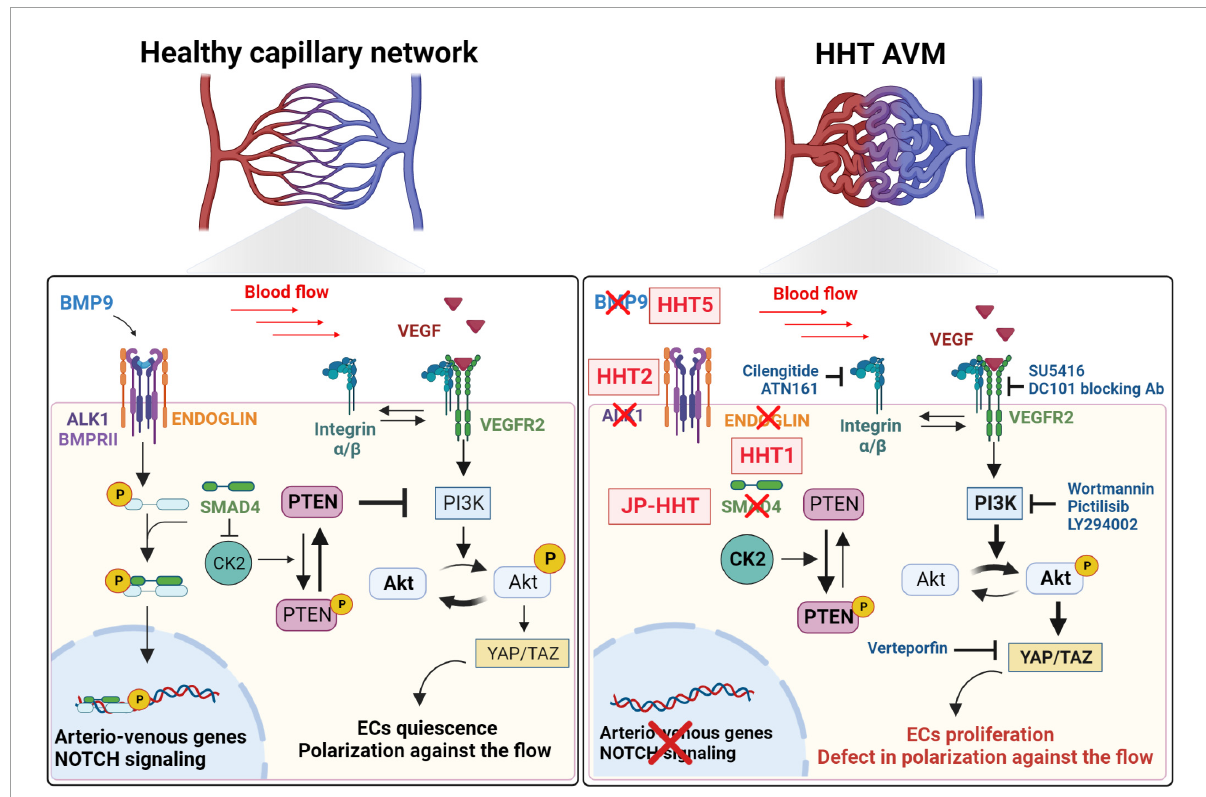
FIGURE2 Signaling pathways known to be involved in the pathogenesis of AVMs. In healthy capillary networks, blood flow potentiates BMP/ALK1 signaling pathway in ECs to regulate the expression of genes involved in arterio-venous specification and NOTCH signaling pathway. BMP/ALK1/SMAD4 pathway will inhibit blood flow- and VEGFR2-induced PI3K/AKT signaling. Indeed SMAD4 inhibits the expression of CK2, which allows the phosphorylation, and inhibition of PTEN, a negative regulator of the PI3K/AKT signaling, which will promote ECs quiescence and polarization against the flow. HHT1, HHT2, JP-HHT, and HHT5 are induced by ENG , ACVRL1 (ALK1), SMAD4, and GDF2 (BMP9) heterozygous mutations, respectively. CK2 inhibition is removed and its expression increases leading to an enhanced phosphorylation of PTEN which will not be able to inhibit PI3K/AKT signaling induced by blood flow and VEGFR2. Increased AKT phosphorylation leads to higher YAP/TAZ expression and activity, hyperproliferation of ECs and migration defects against the